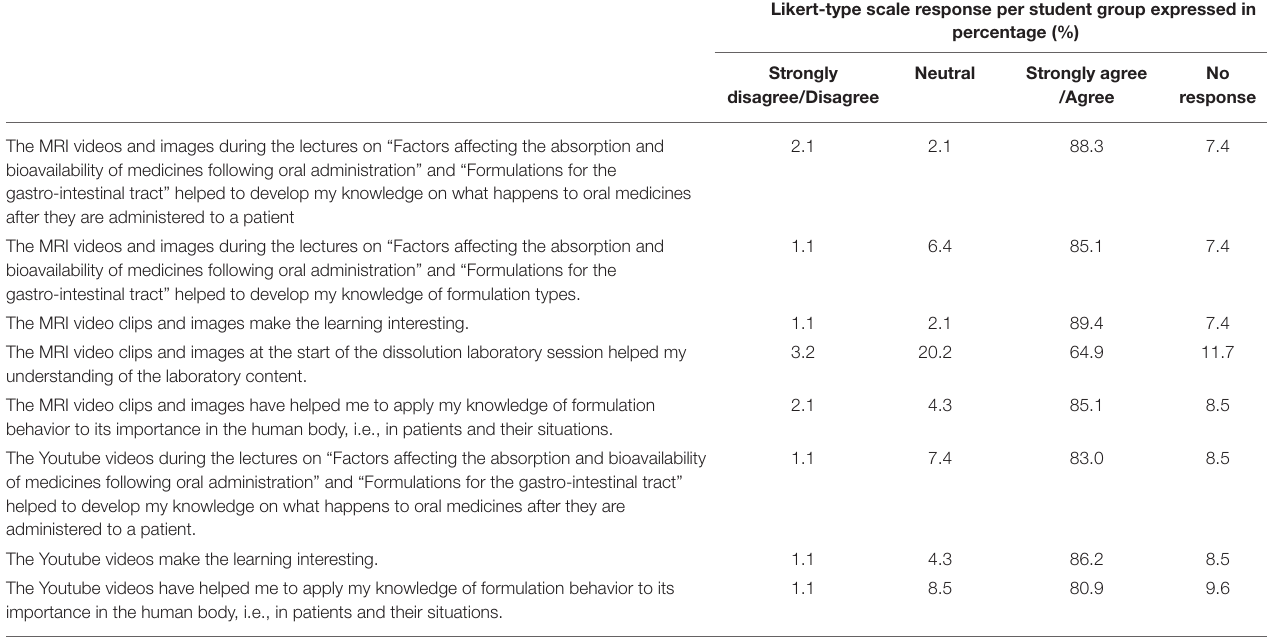
TABLE 5 | Percentage of responses to each Likert-type question across all students, including no responses.